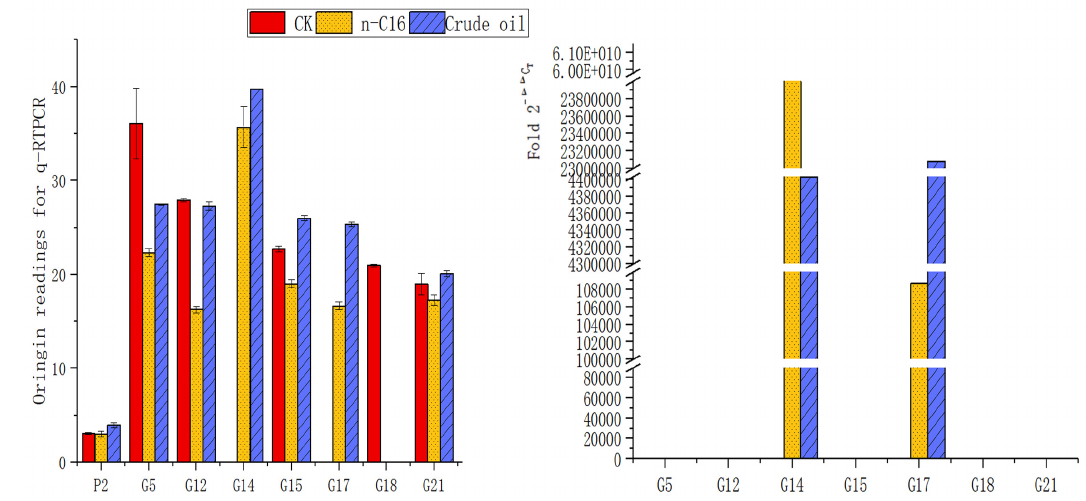
Figure 7. Comparison of gene expression induced by different carbon sources. Left: Original readings of qRT-PCR amplification for alkane-degrading genes: the reading for G14 and G17 in CK is “0”; the reading for G18 in n -C16 and crude oil is “0”. Right: Fold 2 − ∆∆ C T for different expression levels of alkane degrading